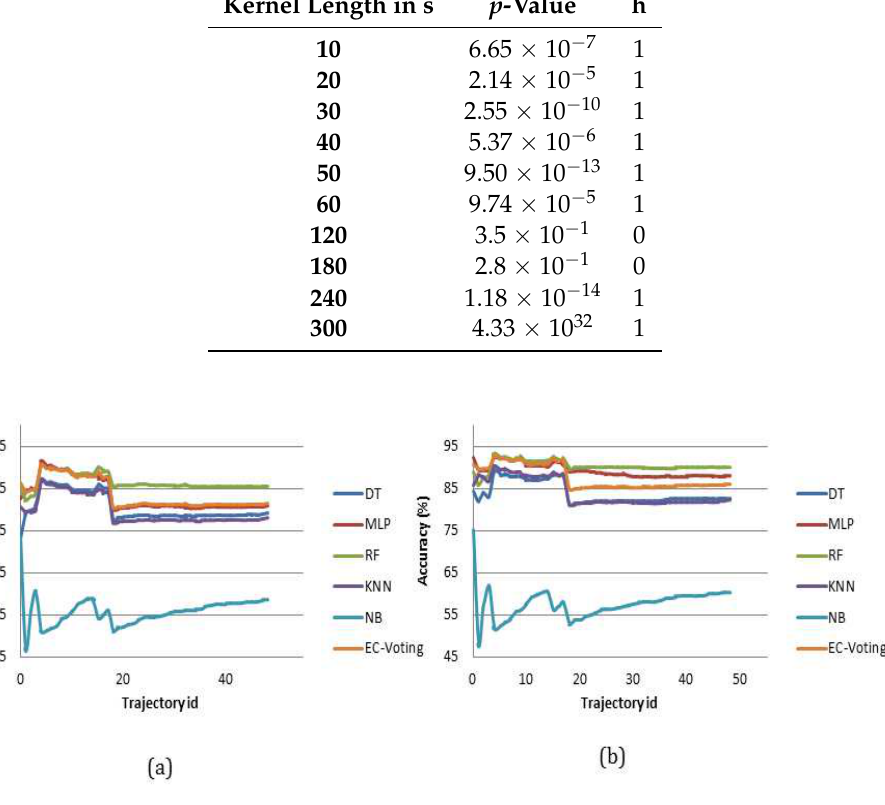
Figure 9. Performance of various classifiers in Layer 1 when using GPS and IMU information at 10 s ( a ) and 60 s ( b ).